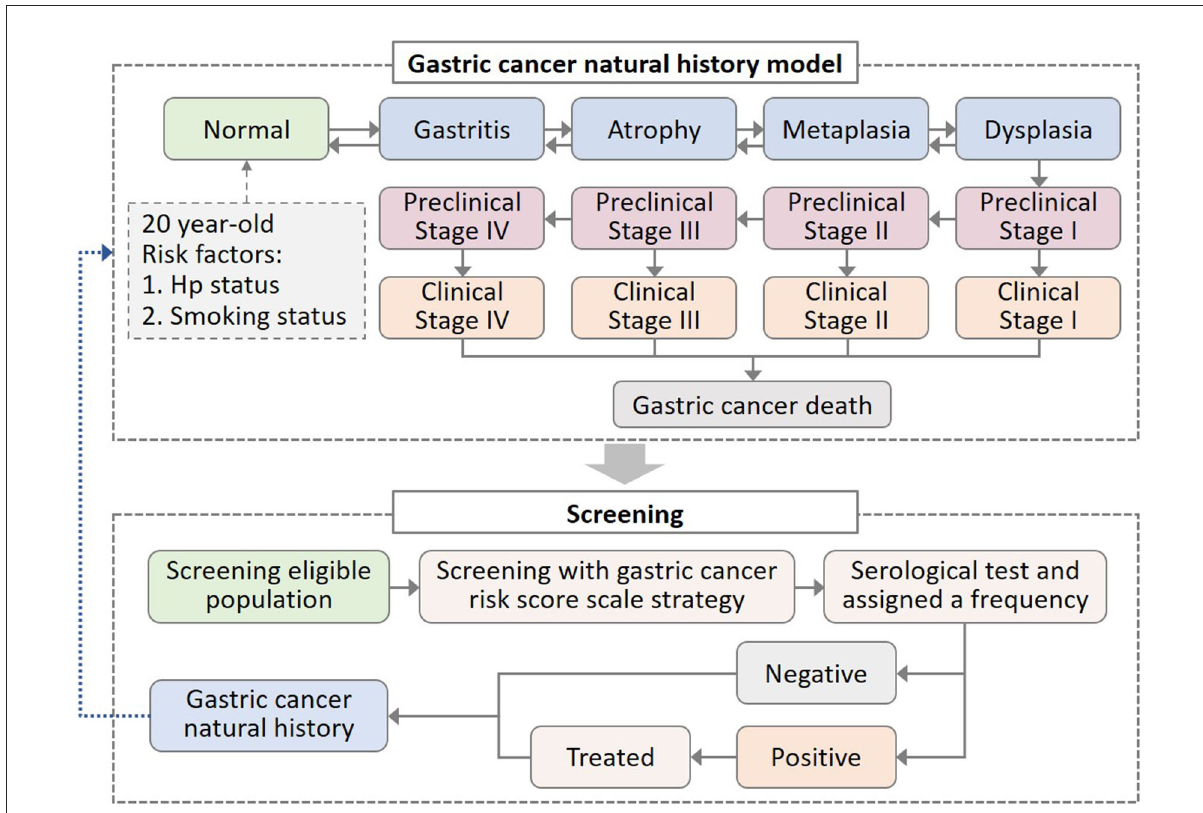
FIGURE1 Decision-making model of gastric cancer (GC) natural history and screening intervention. In the natural history model of GC, all healthy states suffered background mortality, while clinical gastric cancer states suffered additional GC mortality. Hp, Helicobacter pylori .